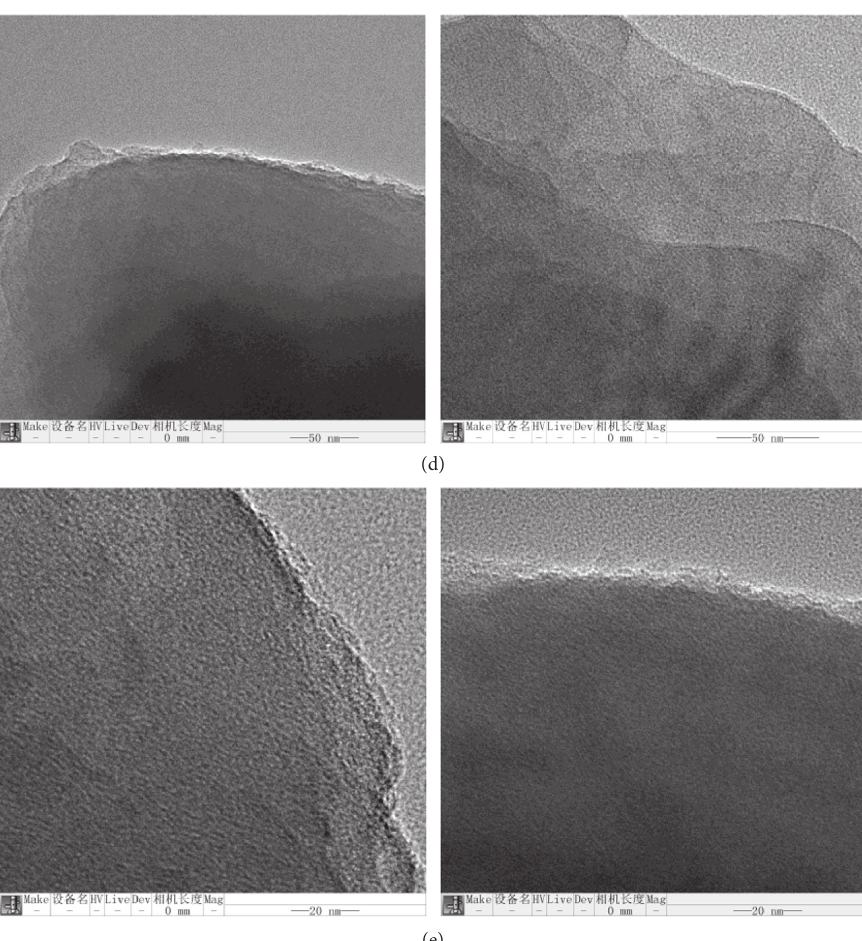
Figure 12: Microstructure and morphology of coal body before loading. (a) 500nm. (b) 200nm. (c) 100nm. (d) 50nm. (e) 20nm.